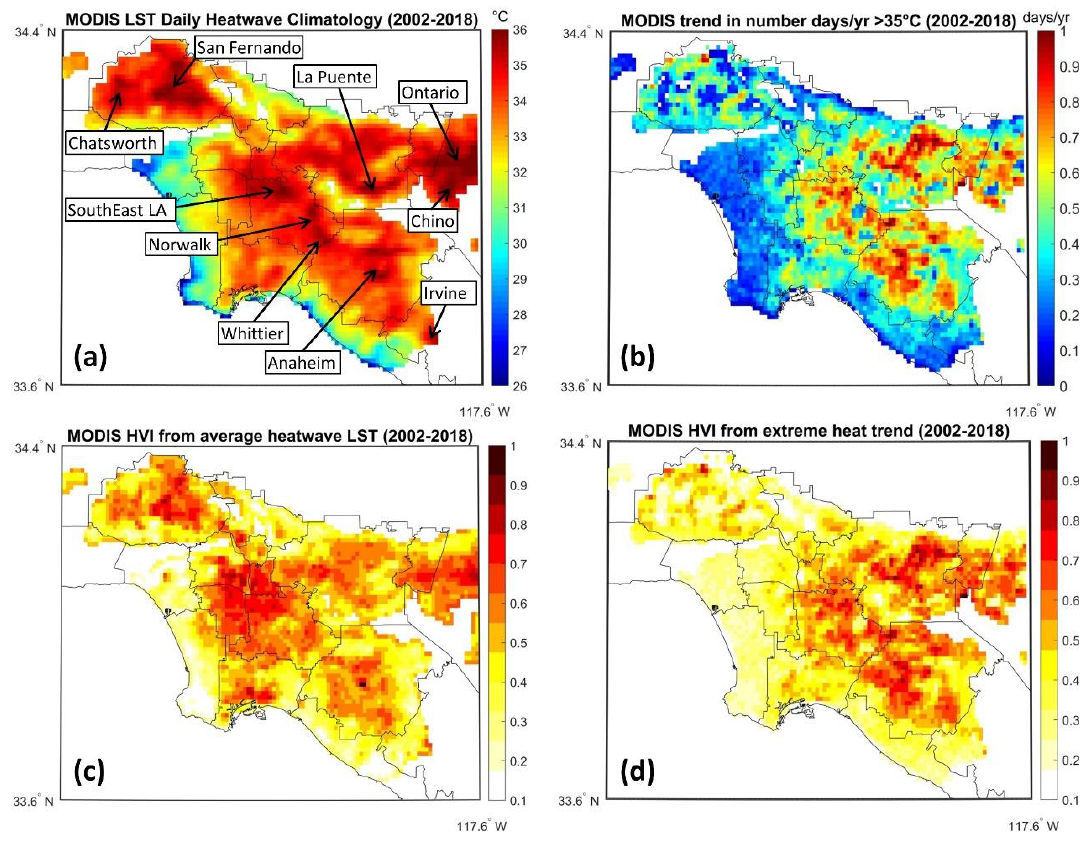
Figure 6. (a) MODIS daily heatwave climatology derived from the MYD21 land surface temperature (LST) product from 2002–2018 at ~1 km resolution; (b) trends (in days/yr) of number of days per year exceeding an average daily LST of 35 °C (only data with significance at < 5% level shown); (c) corresponding HVI map using data from (a), and; (d) corresponding HVI map using data from trends in (b).